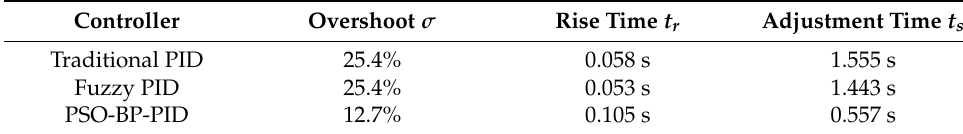
Table 4. Comparison of anti-disturbance performance